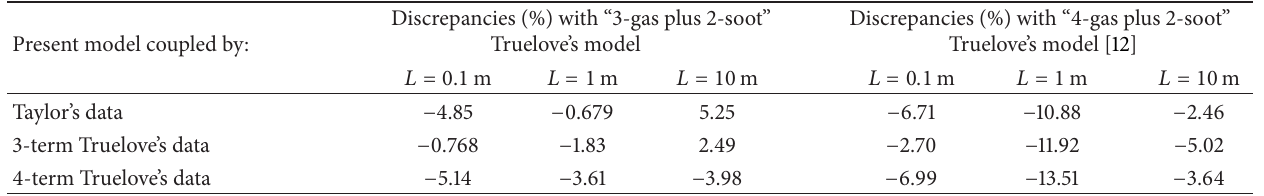
Table 2: Comparison of the calculated total emissivities using the coupled models, with the benchmarks 𝑇 = 1600 ∘ K and 𝐶 𝑠 = 0.0001 Kg/m 3 . Discrepancies (%) with “3-gas plus 2-soot” Present model coupled by: Truelove’s model Taylor’s data